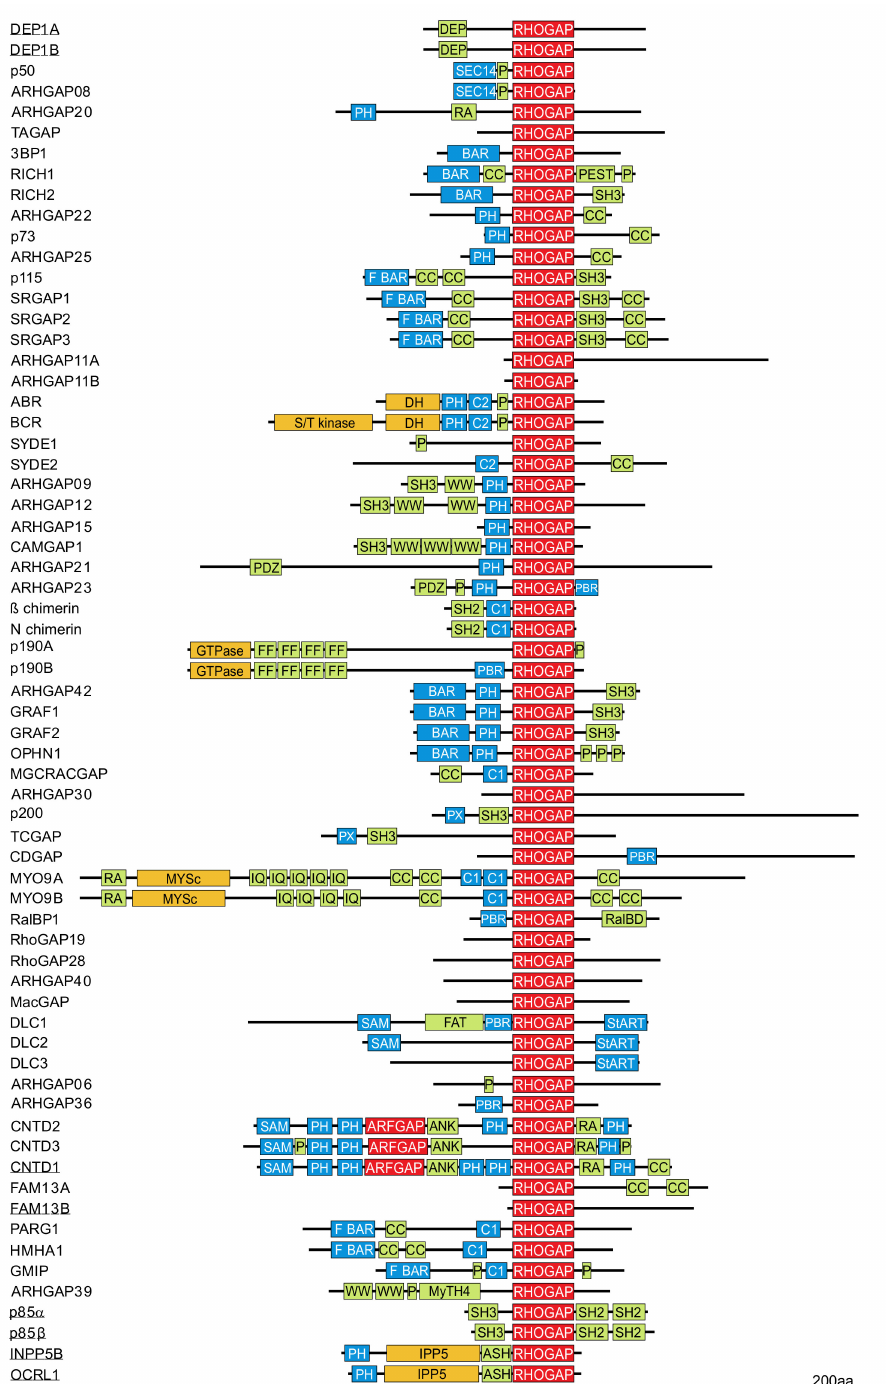
Figure 4. Domain organization of the RHOGAP family proteins (adapted from Amin et al., 2016 [114]). RHOGAPs are mostly multimodular proteins and have a number of functional domains that may mediate cross talk between RHO proteins and other signaling pathways. Functional domains, in addition to the catalytic GAP domain (red), are probably involved in lipid and membrane binding (blue), protein interactions (bright green), and enzymatic activities (red and orange). A scale of amino acid numbers in increments of 200 is shown at the bottom. Underlined proteins are GAP-like proteins with no RHOGAP activity